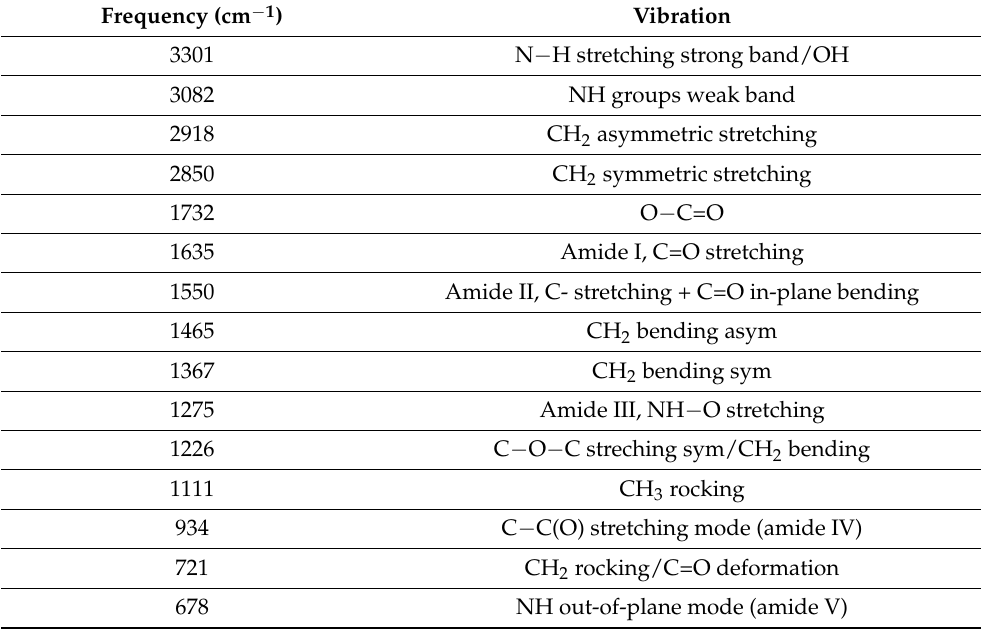
Figure 13. FTIR spectra of hot-pressed PA11 and PA12. Table 5. Curve-fitting results of FTIR spectra for PA11 and PA12